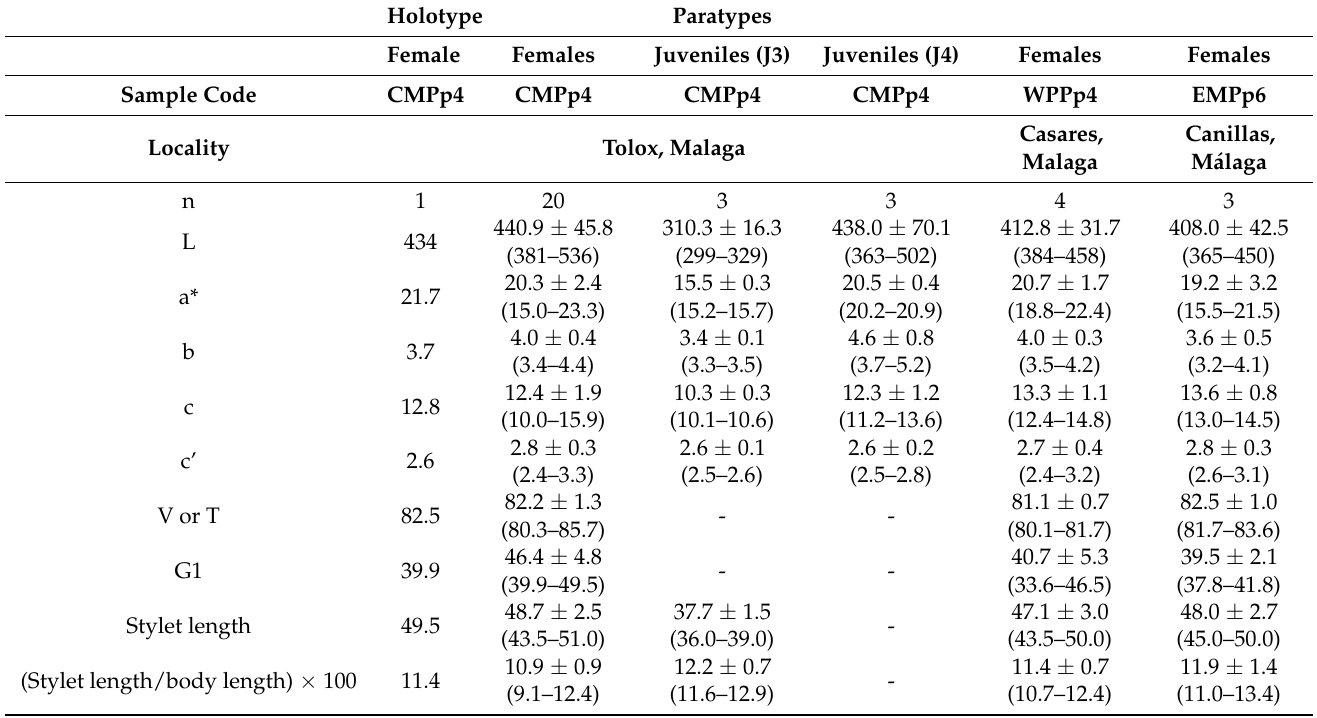
Table 3. Morphometrics of Paratylenchus plesiostraeleni sp. nov. paratype females, third- and